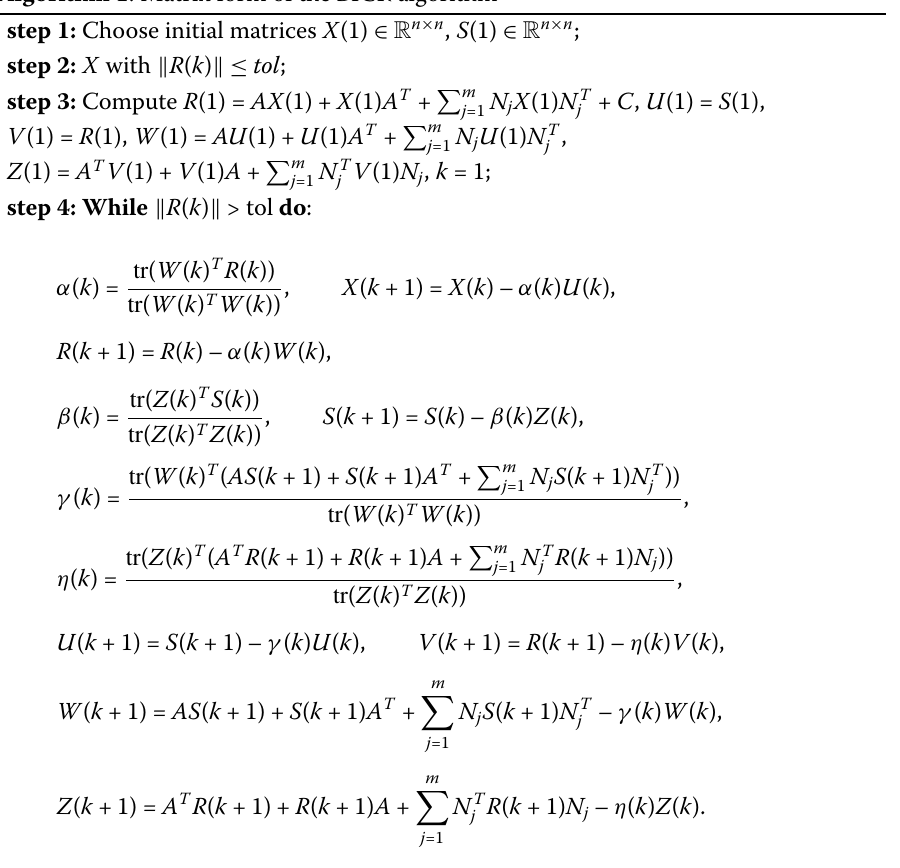
Algorithm 1: Matrix form of the BICR